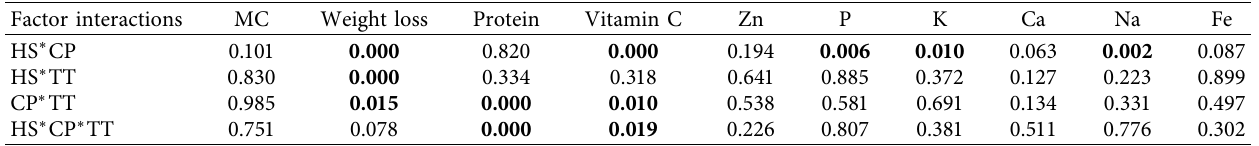
Table 4: P values of interactions between different treatment factors.